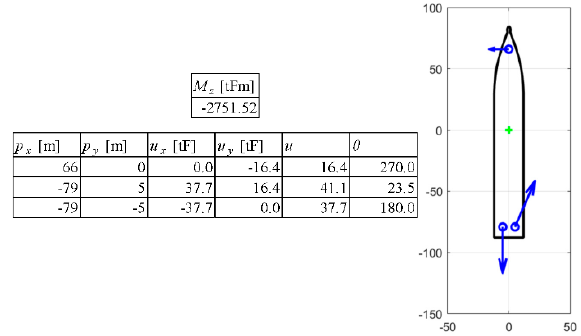
Figure 3. Example of thrust allocation for the simulated vessel.